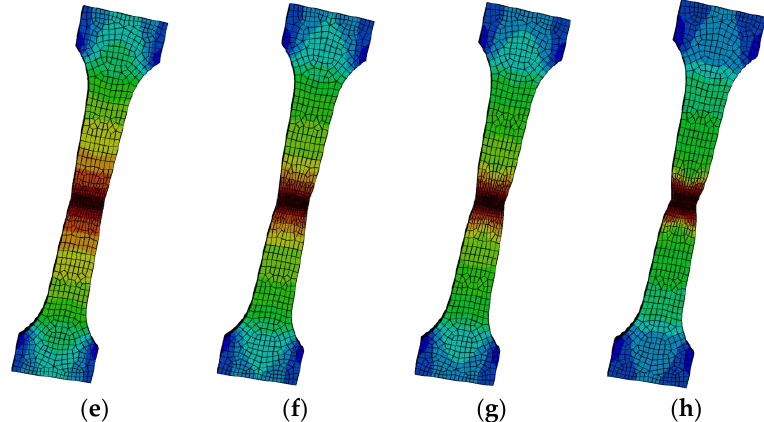
Figure 11. Stretching process of the specimen in finite element simulation. ( a ) chuck displacement 1.3 mm; ( b ) chuck displacement 6.4 mm; ( c ) chuck displacement 15.6 mm; ( d ) chuck displacement 17.6 mm; ( e ) chuck displacement 18.3 mm; ( f ) chuck displacement 19.3 mm; ( g ) chuck displacement 20.3 mm; ( h ) chuck displacement 21.1 mm.